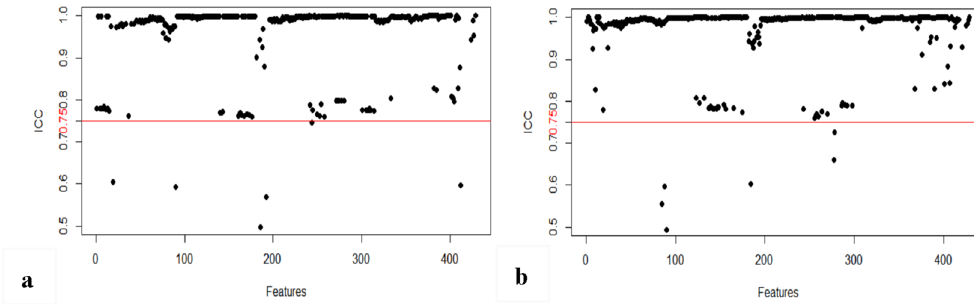
Figure 3. Consistency test of radiomics features. Evaluation of stability and consistency of radiomics features based on interreader ( a ) and intrareader ( b ) correlation coefficient (ICC), ICC > 0.75 (above the red line) indicates that the feature has good stability or inter and intrareader consistency.